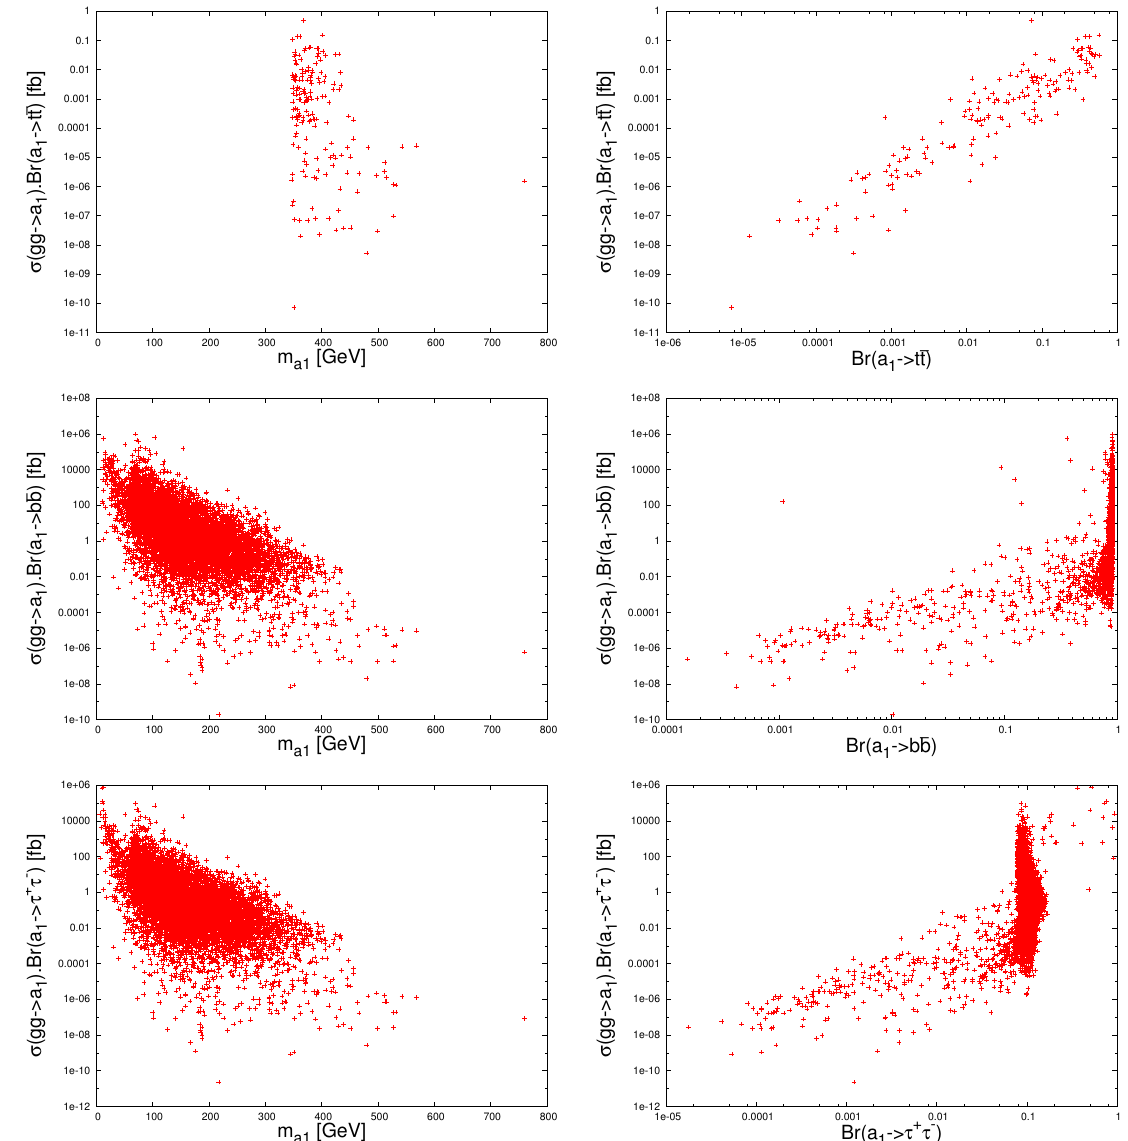
Figure 1. The production rates σ ( gg → a 1 ) Br ( a 1 → t ¯ t ) ( top ) σ ( gg → a 1 ) BR ( a 1 → b ¯ b ) ( middle ) and σ ( gg → a 1 ) BR ( a 1 → τ + τ − ) ( bottom ) as functions of m a ( left ) and of the corresponding branching ratios ( right ) 1